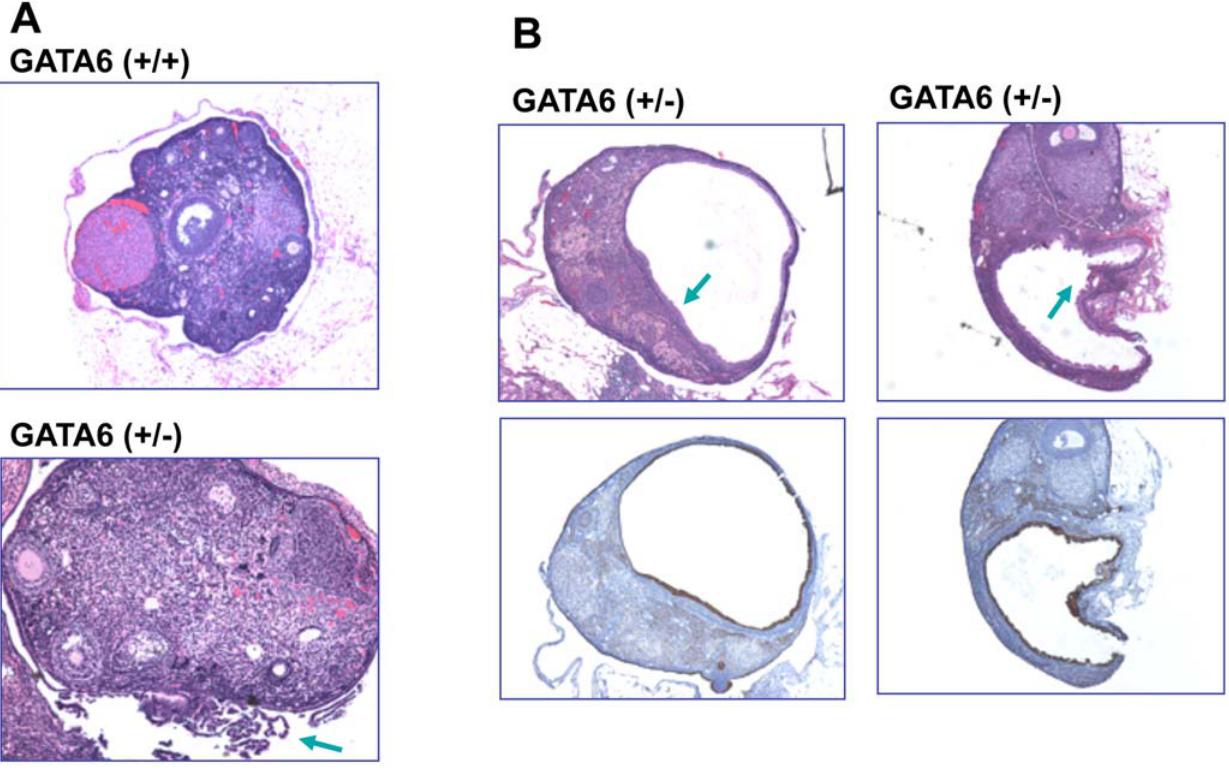
Figure 6. Ovarian morphology of GATA6 heterogeneous mice. The ovarian morphology of GATA6 ( + / 2 ) and wildtype littermates of about one year of age was compared. Cytokeratin staining was used as a marker for epithelial cells. A . A typical example of a wildtype ovary shows numerous follicles in various developmental stages enclosed inside a layer of surface epithelium. A representative GATA6 ( + / 2 ) ovary shows the presence of outgrowth of epithelial cells from the surface (arrow). B . A large portion of GATA6 ( + / 2 ) ovaries also exhibits large cysts inside the ovaries. The cells lining the cysts are cytokeratin positive (lower panels). All images were taken under a microscope with a 100 6 magnification.